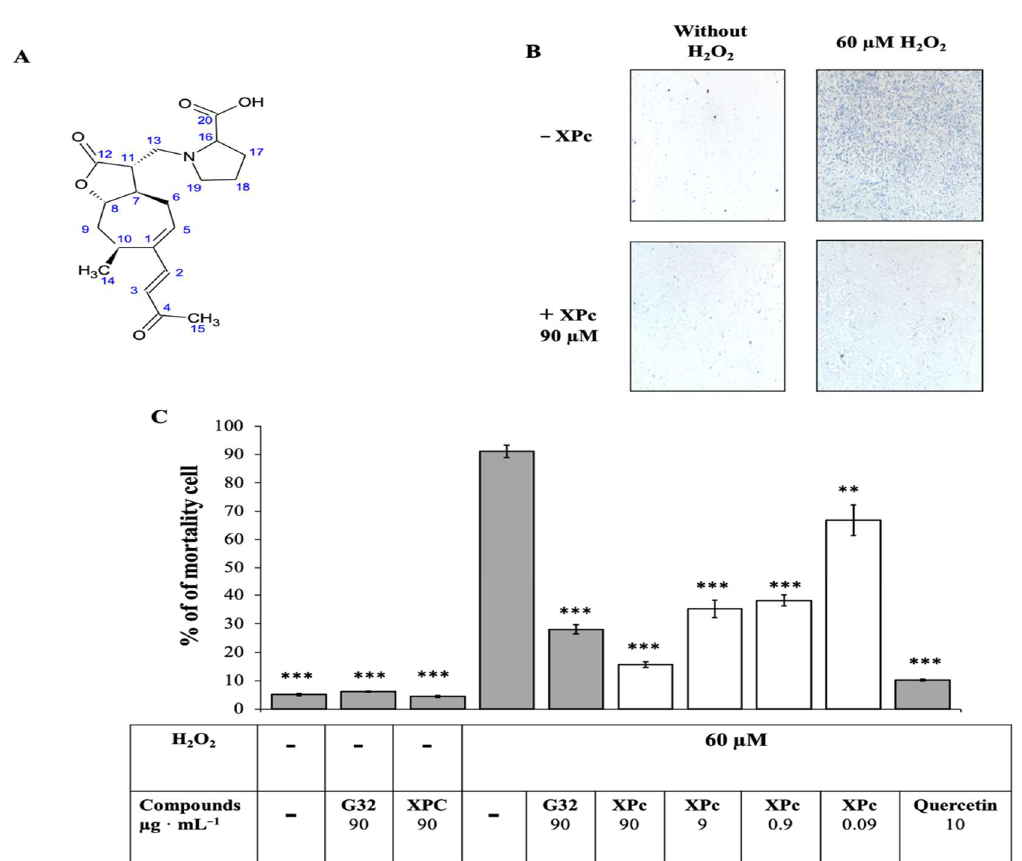
Figure 4. Chemical structure and H 2 O 2 protection effect of XPc: ( A ) structure of XPc (Xanthalin-13-(pyrrolidine-2-carboxylic acid)); ( B ) images of L6 cells after trypan blue dye treatment with and without induction of H 2 O 2 oxidative stress and with or without 12 h pretreatment with XPC; and ( C ) protective effect of XPc at different concentrations against artificial oxidative stress induced by H 2 O 2 on myocytes comparison with G32 extract. Quercetin used as positive control. Values are the means ( ± SD) ( p < 0.01 (**), (***) p < 0.001).